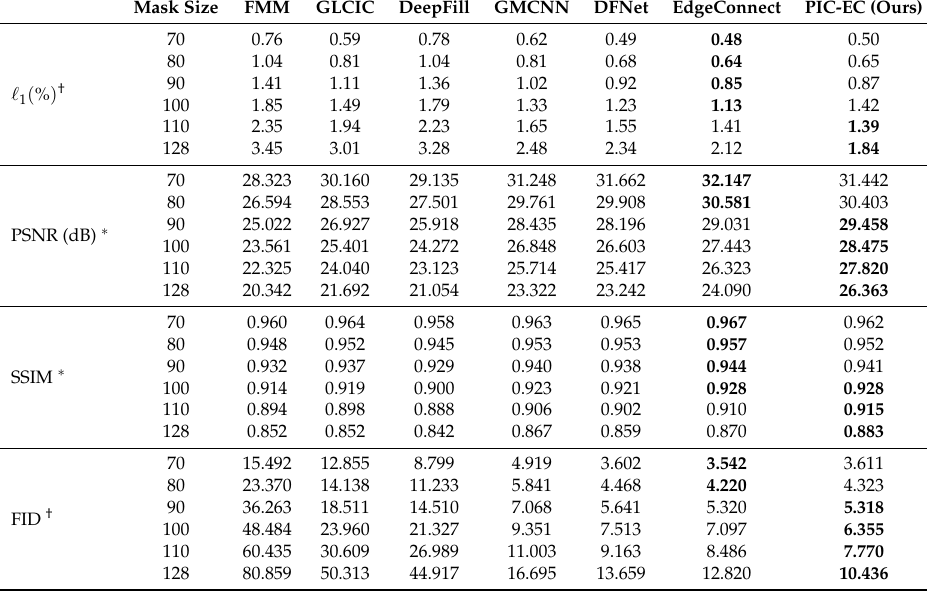
Table 3. Quantitative results over CelebA-HQ for six different squared masks with methods: FMM, GLCIC, DeepFill, GMCNN, DFNet, EdgeConnect and PIC-EC. Boldface in each row indicates the best performance. ∗ Higher is better. † Lower is better. FMM: Fast Marching Method, GLCIC: Globally and Locally Consistent Image Completion, GMCNN: Generative Multi-column Convolutional Neural Networks, PIC-EC: Parallel Image Completion with Edge and